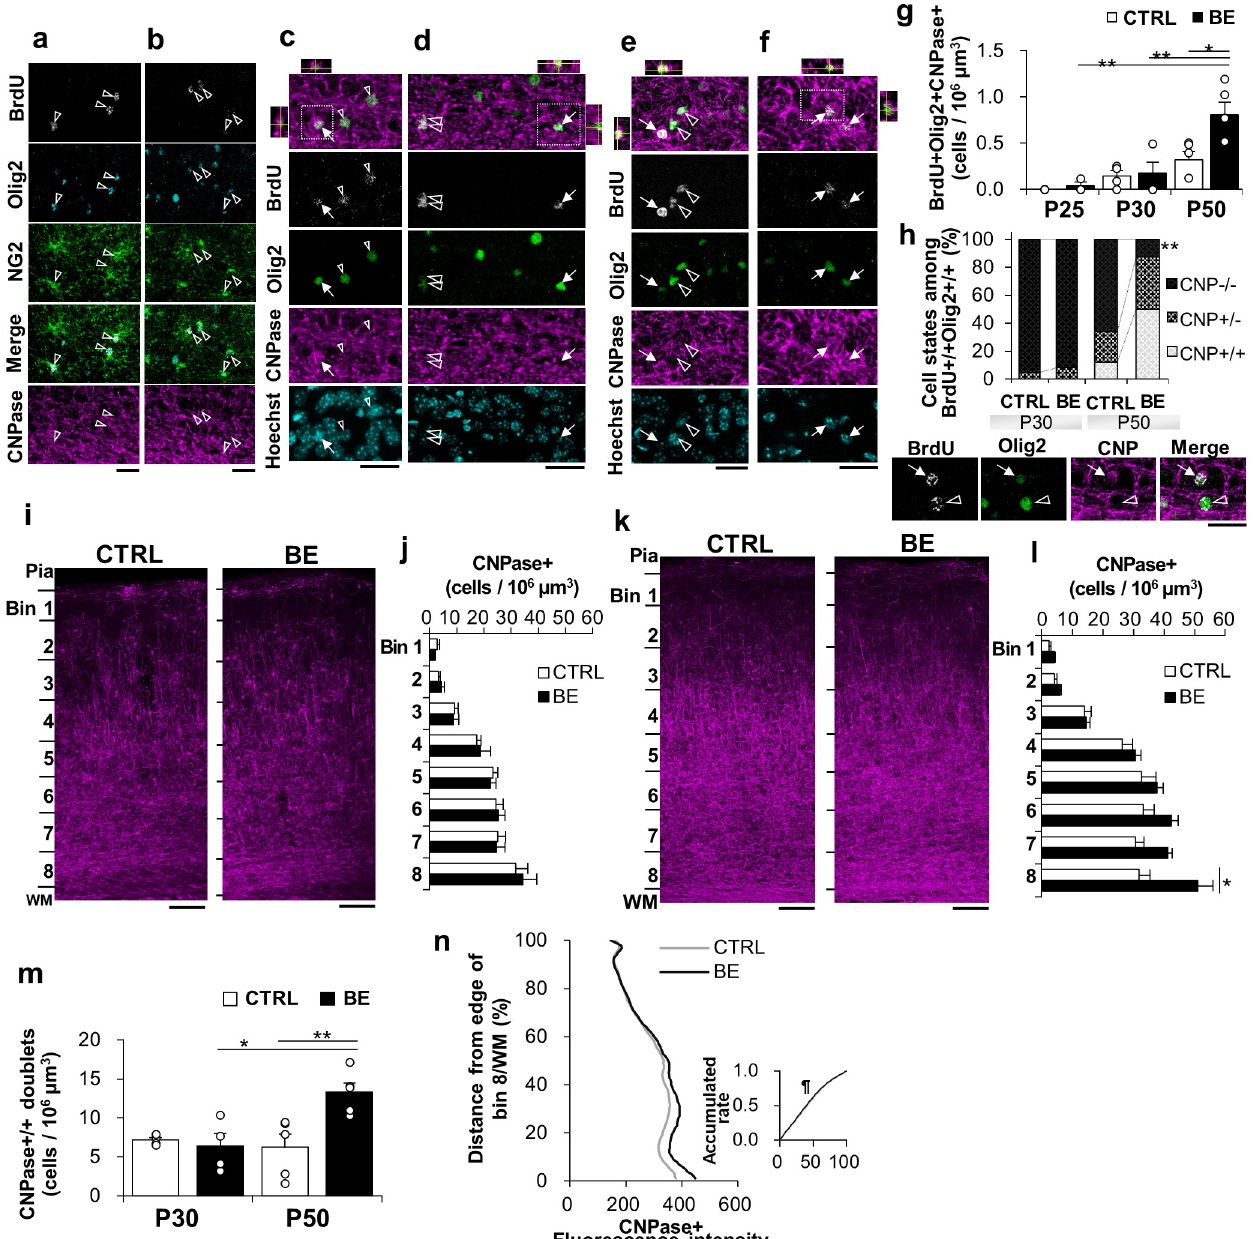
Fig 7. Maturation of P22-25 proliferated OPCs. ( a , b ) Confocal images of BrdU (gray), Olig2 (cyan), NG2 (green), and CNPase (magenta) at P25 for control ( a ) and BE ( b ) mice. Most of the BrdU-labeled cells were Olig2+NG2+CNPase- cells. Merged images of the fourth row omitted CNPase for clarity. Arrowheads indicate BrdU+Olig2+NG2+CNPase- cells. Scale bar, 20 μ m. ( c-f ) Confocal images of BrdU (gray), Olig2 (green), and CNPase (magenta) stain with Hoechst (cyan) in bin 8 of V1 at P30 ( c , d ) and P50 ( e , f ) for control ( c , e ) and BE ( d , f ) mice. Merged images of the top row omitted Hoechst for clarity. Arrows and open arrowheads indicate maturing oligodendrocyte (BrdU+Olig2+CNPase+) and OPC/pre-OL (BrdU+Olig2+CNPase-), respectively. The x-z and y-z cross-section views of white box images are shown at the top and left/right side of the box, respectively. Scale bars, 20 μ m. ( g ) Cell densities of maturing oligodendrocytes (BrdU+Olig2+CNPase+) at P25, P30, and P50. ( h) Percentage of CNPase labeling among BrdU+Olig2+ doublets at P30 and P50. ( i-l) CNPase (magenta) expression in V1 at P30 ( i ) and P50 ( k ). Scale bars, 100 μ m. Laminar analysis of CNPase-labeled cells throughout the cortex at P30 ( j ) and P50 ( l ). � p < 0.05, one-way ANOVA. ( m ) The cell density of CNPase+ doublets in bin 8 at P30 and P50. For ( g) , ( h) , and ( m) , � p < 0.05; �� p < 0.01, two- way ANOVA with Tukey-Kramer post hoc tests, N = 3 for P25; N = 4 for P30; N = 5 for P50. ( n ) CNPase+ fluorescence intensity in V1 at P50. Insert , Cumulative distribution analysis using Kolmogorov–Smirnov test shows more CNPase expression in BE mice: ¶p = 0.00003 ( D-stat = 0.020, D-crit = 0.011).